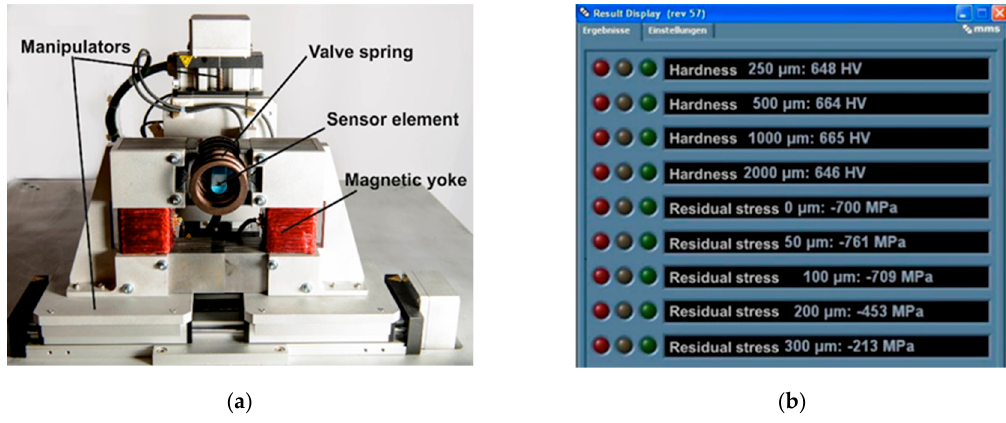
Figure 27. 3MA valve spring scanner system: ( a ) measuring system and ( b ) application for depth‐dependent determination of hardness (Hd) and residual stress (RS).